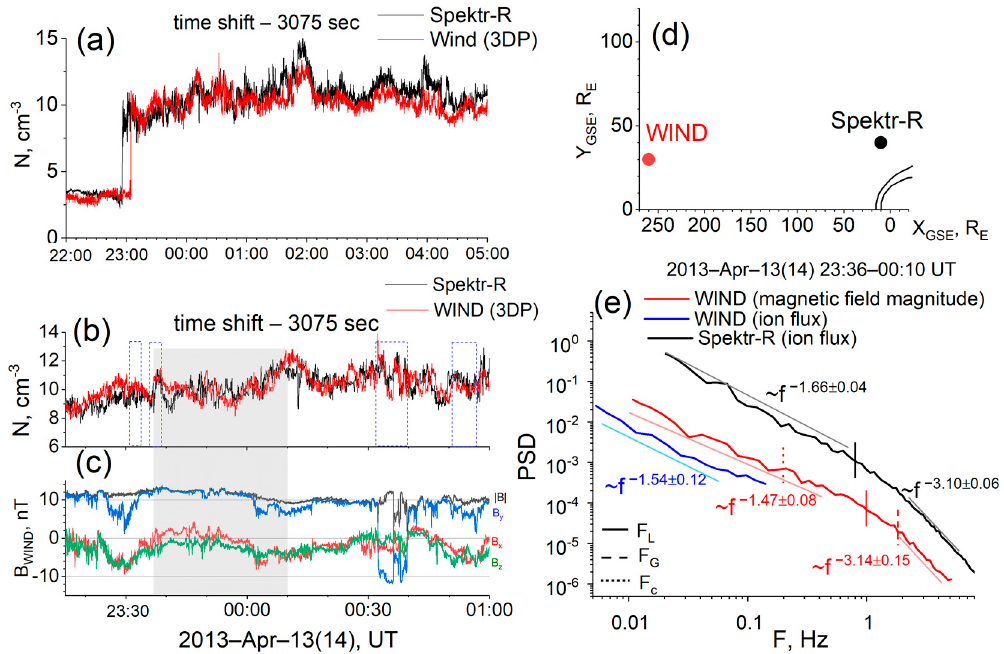
Figure 1. ( a , b )—density measurements at Spektr-R (black line) and WIND 3DP (red line) on 14 April 2013; WIND data are shifted in time by 3075 sec; ( c ) WIND magnetic field components, shifted by the same time; ( d ) s/c positions for the analyzed case; ( e ) comparison of the normalized magnetic field magnitude (red line) and ion flux (blue line) spectra at WIND and ion flux spectrum at Spektr-R (black line) for the analyzed case.